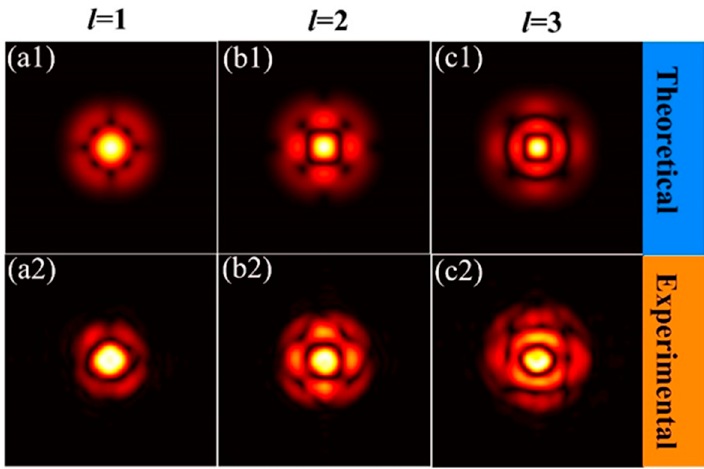
Figure 12. The modulus of the focal plane DOC ( | µ ( ρ ,0 ) | ) of an HGCSMLG 0l beam with l = 2 for different beam orders m , n .